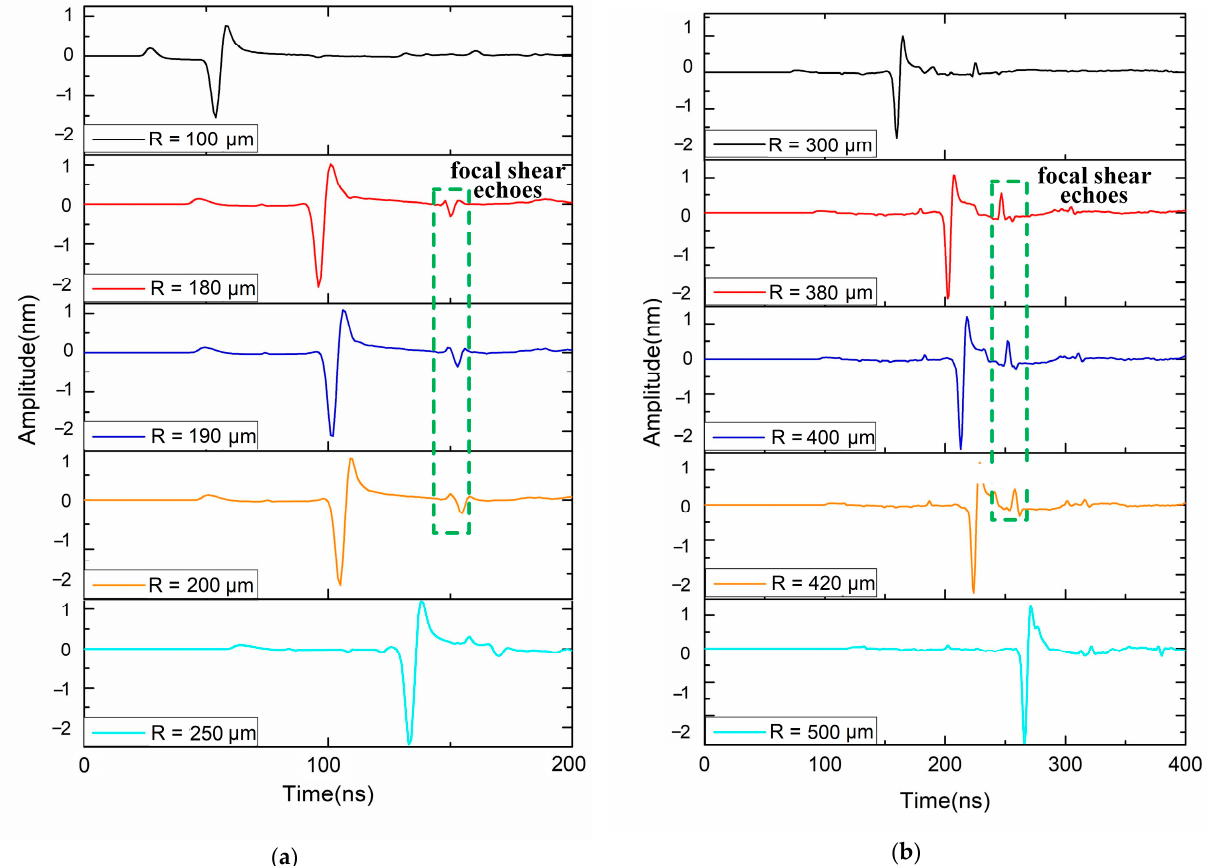
Figure 9. Typical simulation results of displacement at the ring center for the thickness measurement of ( a ) 1st layer and ( b ) 2nd layer.